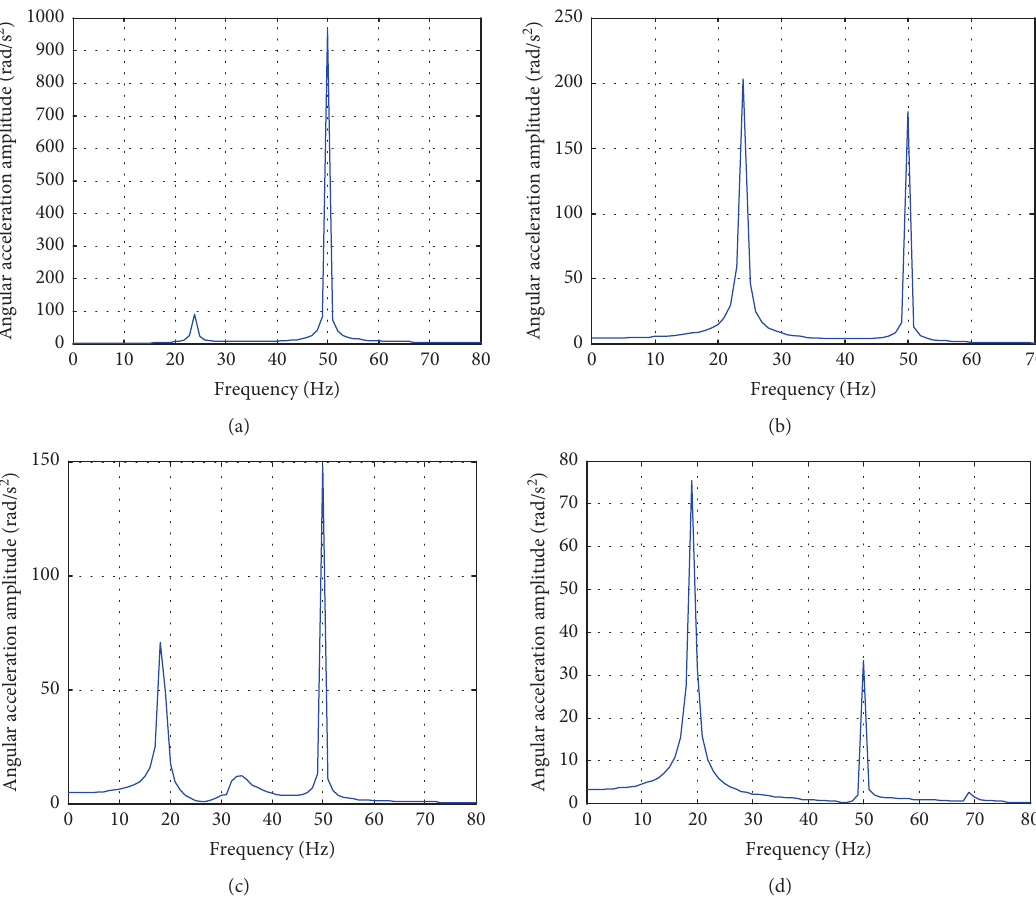
Figure 14: Spectra of J 8 and J 10 at 1500r/min of engine speed: (a)spectrum of J 8 and (b) spectrum of J 10 of DMF; (c) spectrum of J 10 of DMF with simple CPVA; (d) spectrum of J 10 of DMF with bifilar CPVA.